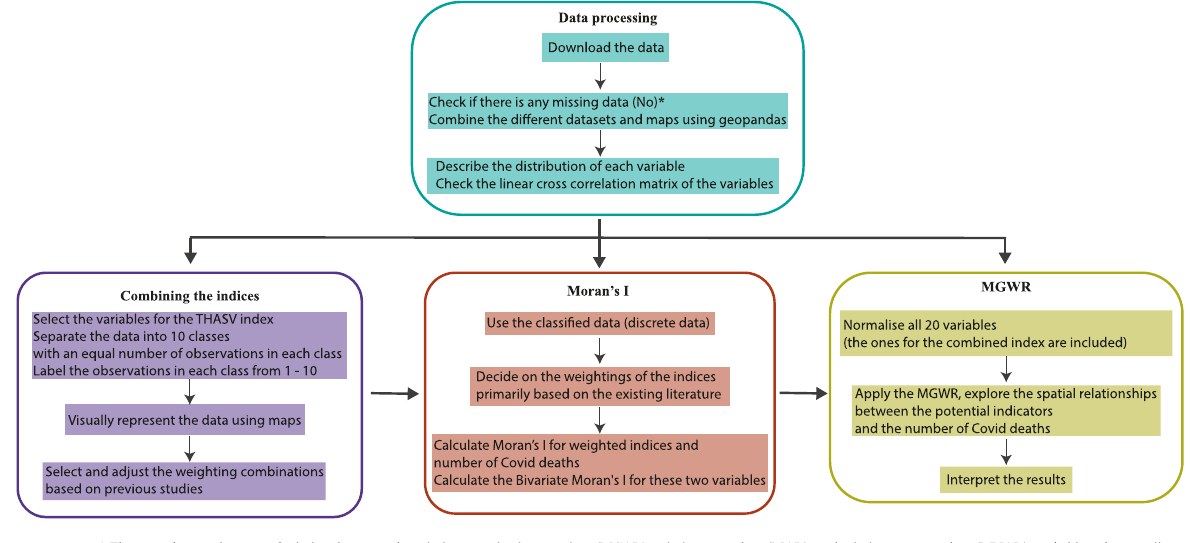
Fig. 1 Workflow of the research